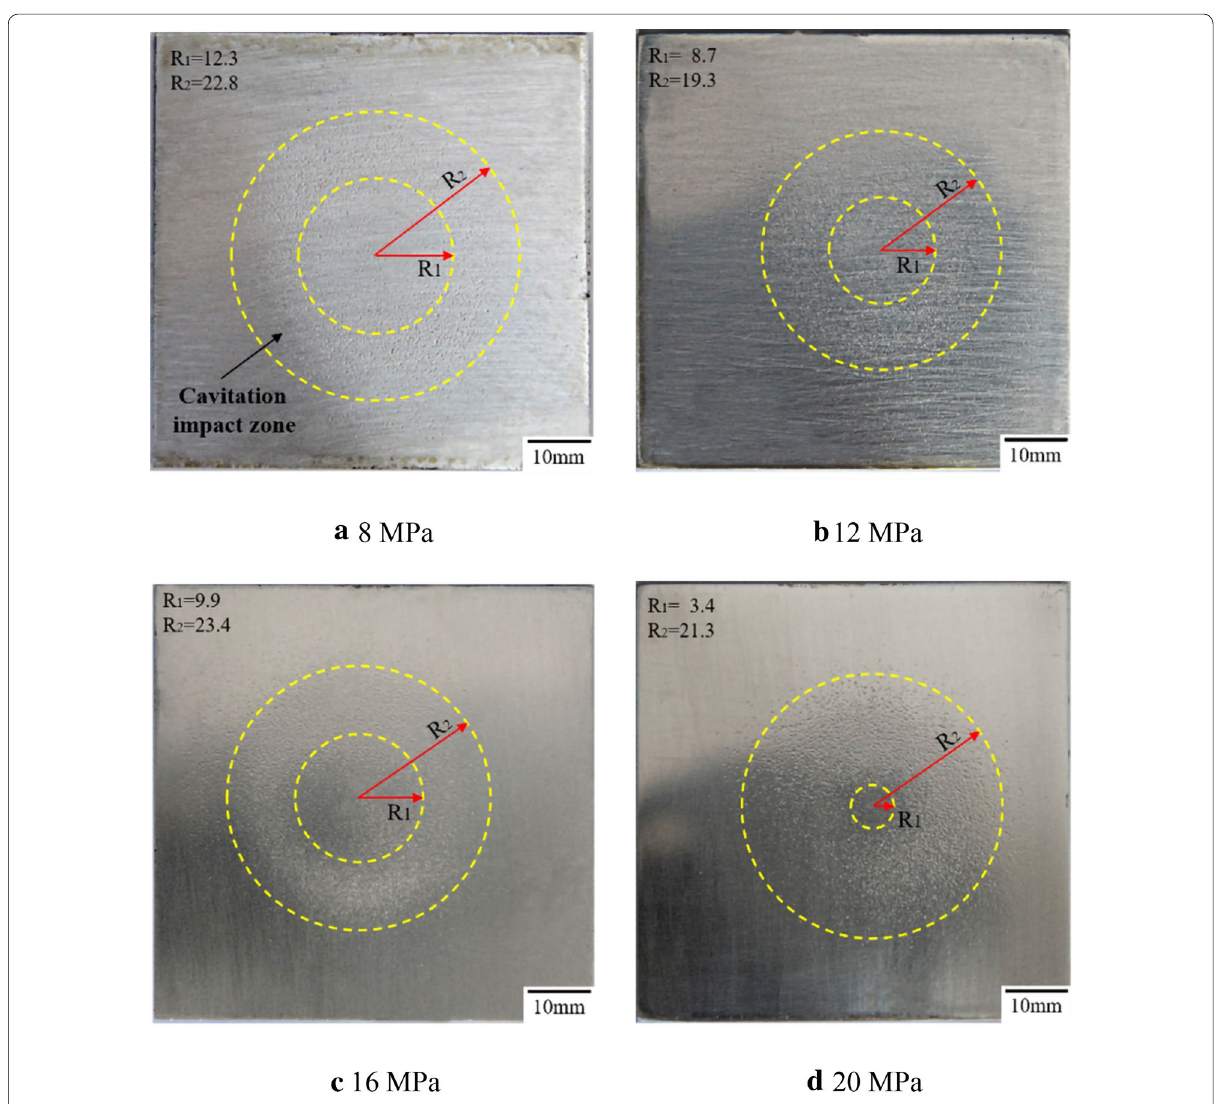
Figure 3 Impact zone of cavitation water jet under different incident